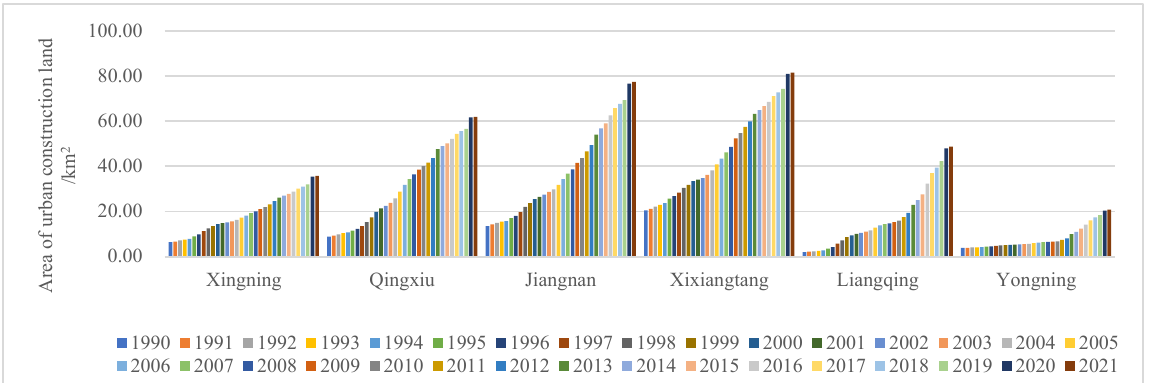
Figure 4. Temporal evolution characteristics of each district from 1990 to 2021.